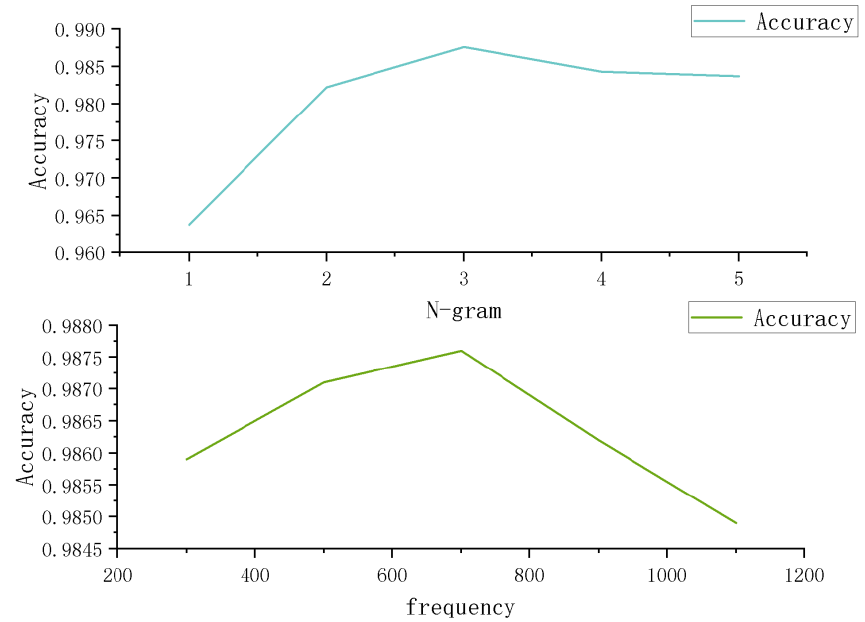
Figure 12. Experiment on the selection of N value and frequency.